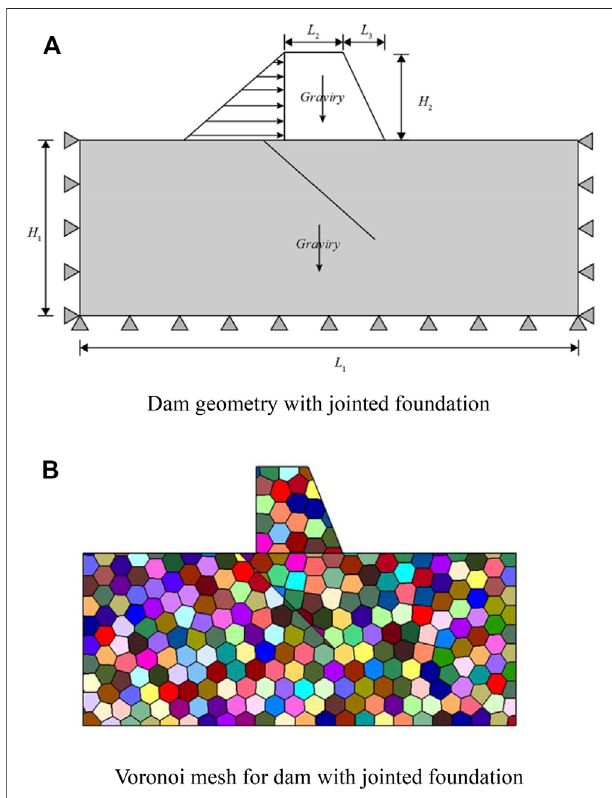
FIGURE12 | The geometric parametersand Voronoi mesh fordam with joint. (A) Dam geometry with jointed foundation. (B) Voronoi mesh for dam with jointed